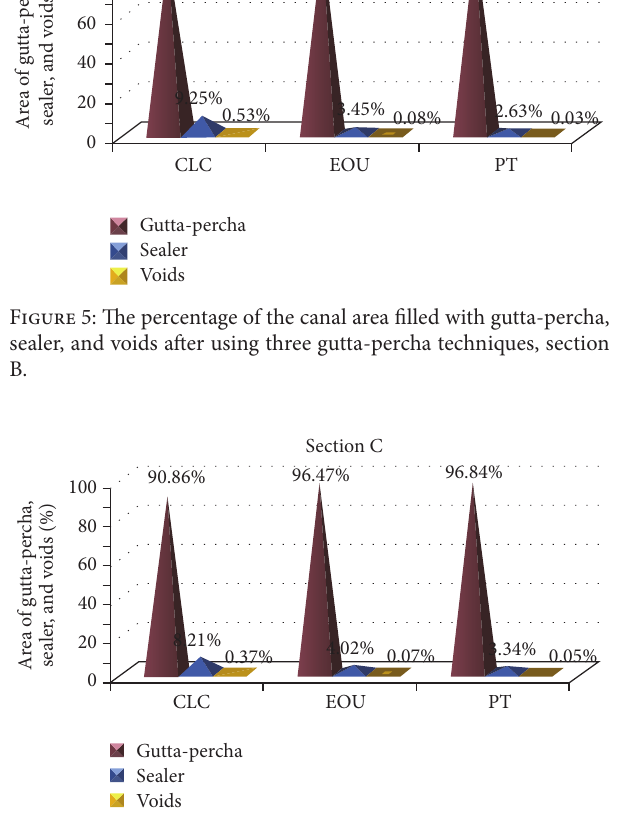
Figure 6: The percentage of the canal area filled with gutta-percha, sealer, and voids after using three gutta-percha techniques, section C.